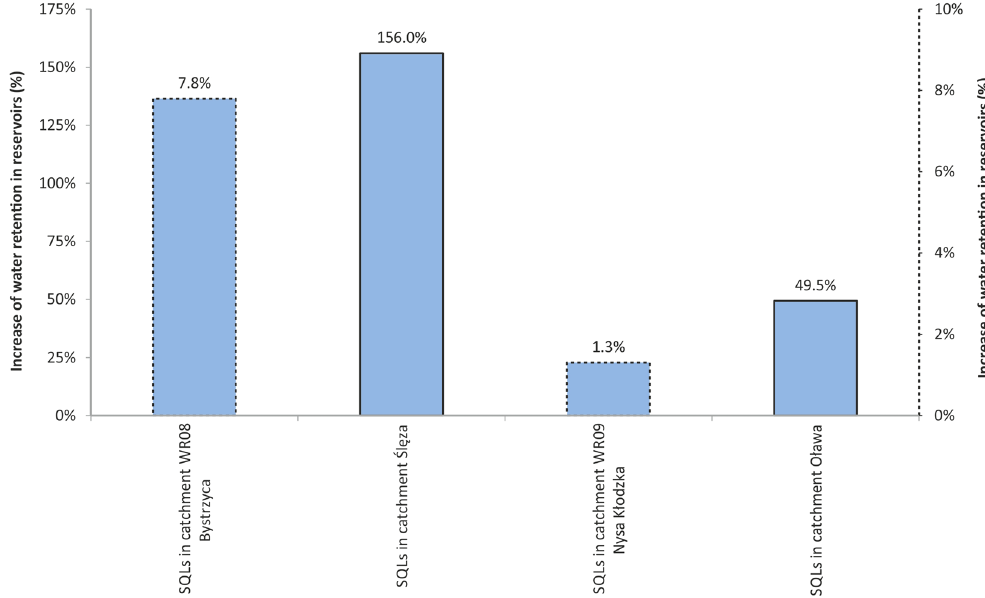
Figure 6. The influence of the volume of water retained in Strzelin Quarry Lakes on the increase in small-scale reservoir and pond retention in catchments [left scale (solid line)—the increase of water reservoirs retention in catchments, for columns with solid border lines; right scale (dotted line)—the increase of water reservoirs retention in catchments, for columns with dotted borders